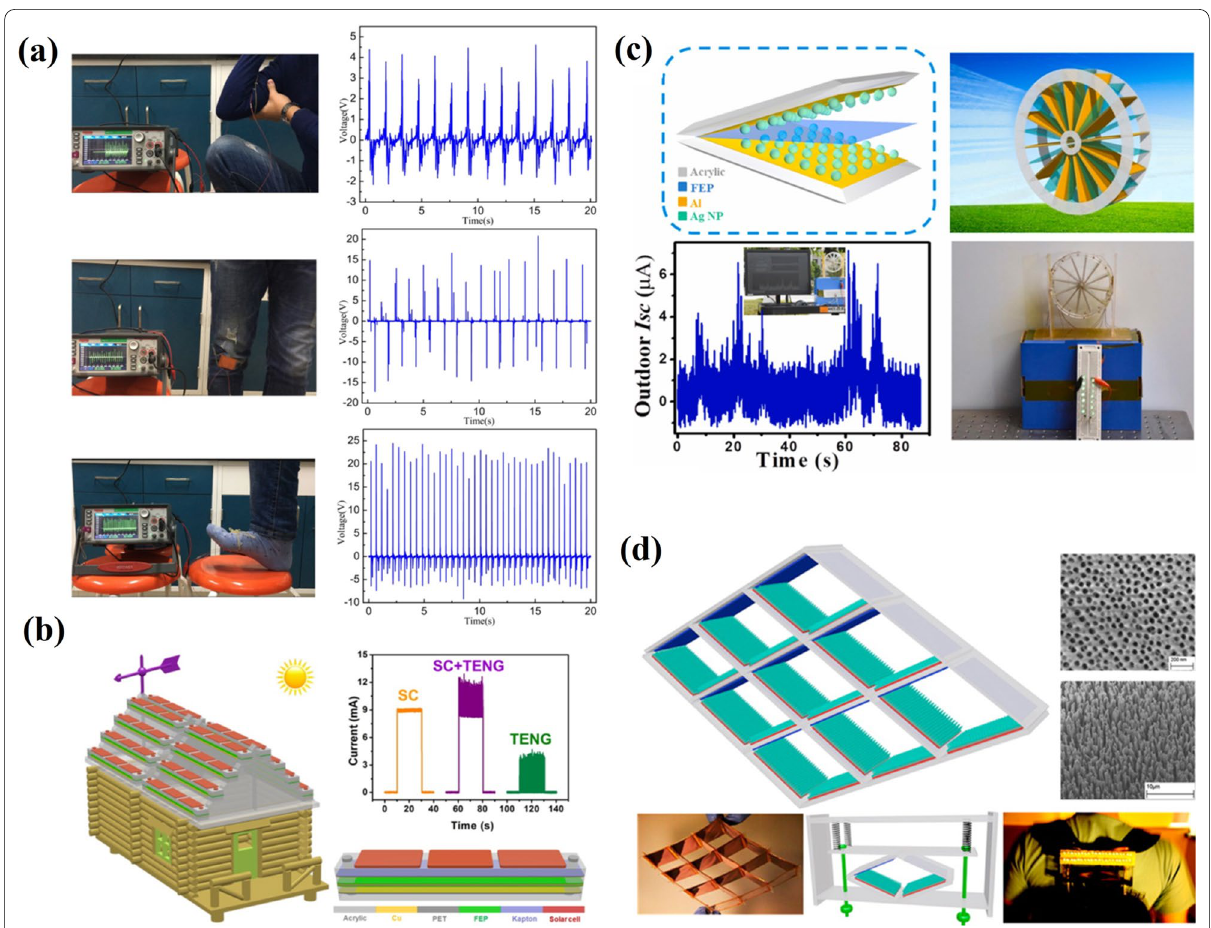
Fig. 17 Applications of TENGs for mechanical energy harvesting: a a flexible TENG harvesting small mechanical energy from different parts of the body (Reproduced with permission from Ref. [113]); b schematic diagram of the integrated hybridized NGs on the roof of a house model (Reproduced with permission from Ref. [114]); c TENG for harvesting environmental wind energy (Reproduced with permission from Ref. [115]); d a self-powered backpack on the basis of a TENG with integrated rhombic gridding for harvesting the vibration energy from natural human walking (Reproduced with permission from Ref.